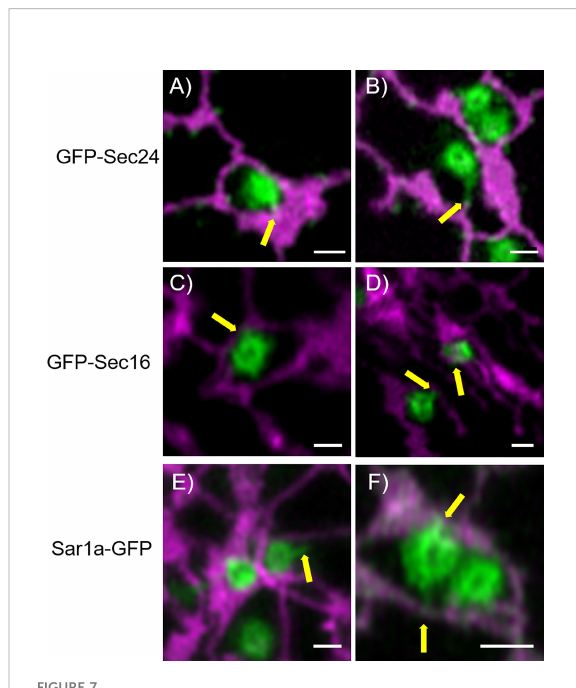
FIGURE 7 COPII components show protrusions that connect with the ER. The ERES markers/COPII components GFP-Sec24 (A, B) , GFP- Sec16 (C, D) and Sar1a-GFP (E, F) show dynamic protrusions (yellow arrows). Proteins are expressed transiently in tobacco leaf epidermal cells. The ER is labelled with the lumenal marker RFP-HDEL (magenta). Size bars = 1